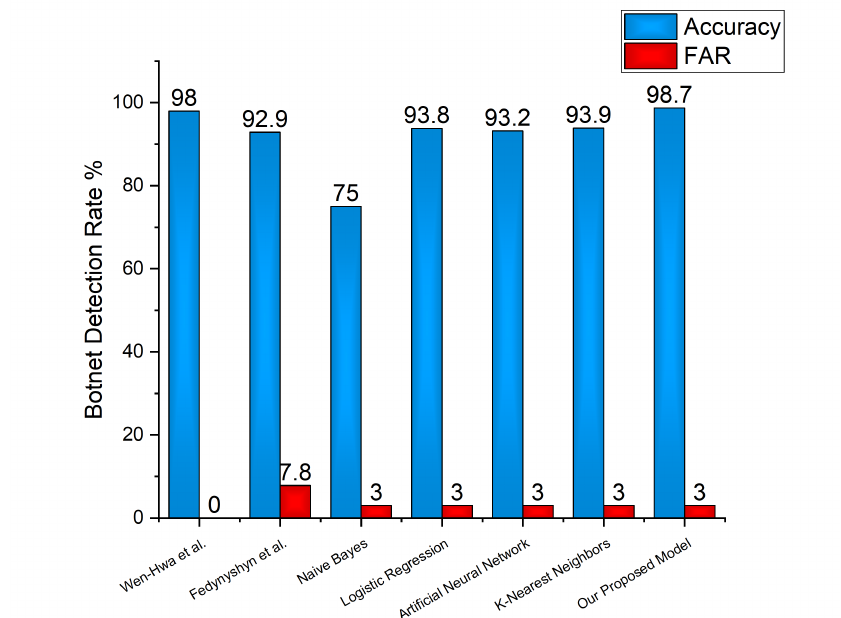
Figure 17. Comparison with other machine learning classifiers on P2P botnet